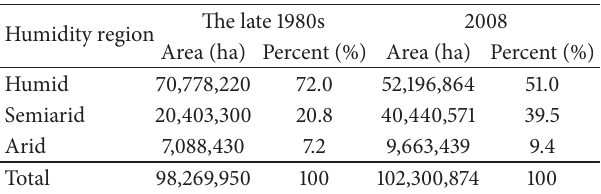
Table 2: Area of farmland in humid, semiarid, and arid zones in northern